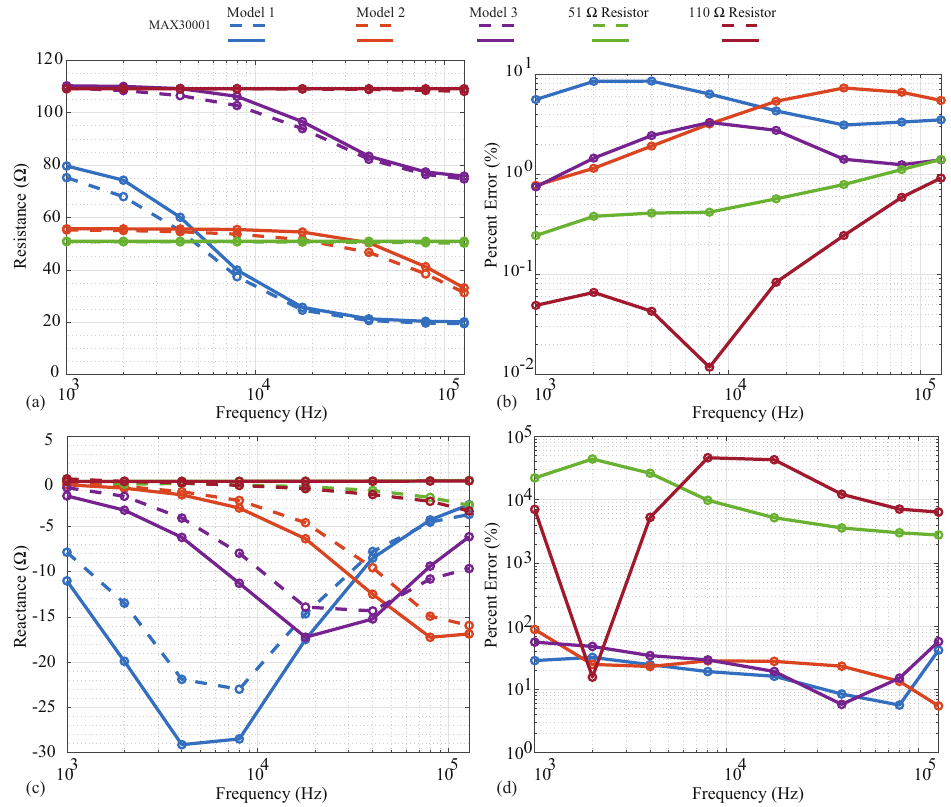
Figure 5. MAX3000x (dashed) and Keysight E4990A (solid) measurements of ( a ) resistance and ( c ) reactance of two resistors (51 Ω , 110 Ω ) and three 2 R − 1 C models. For comparison, the relative errors of the MAX3000x ( b ) resistance and ( d ) reactance compared to the Keysight E4990A data are